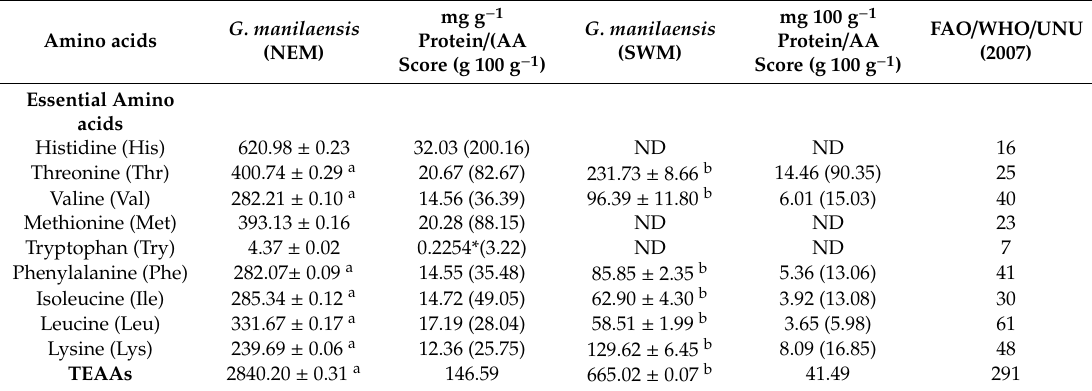
Table 3. Variation in the Amino Acids Composition (mg 100 g − 1 DW) of G. manilaensis